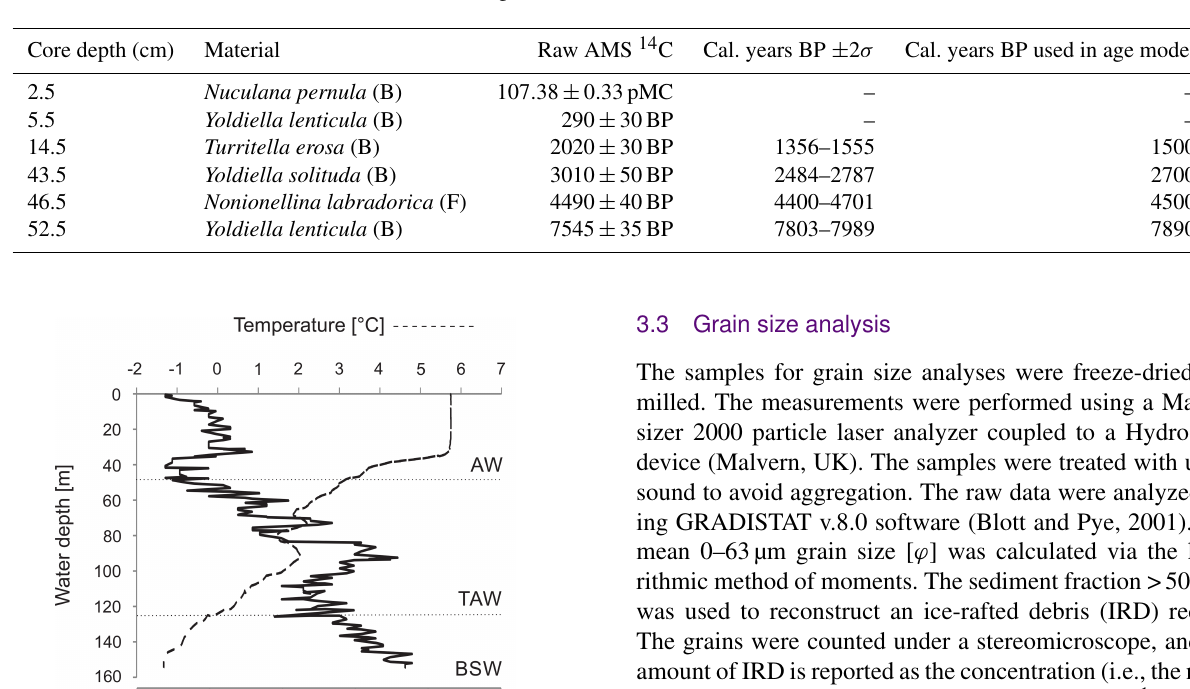
Table 1. Raw and calibrated AMS 14 C dates used in the age model. B stands for bivalve shells, while F stands for benthic foraminifera tests.